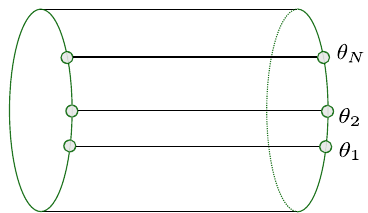
Figure 15 . Graphical representation of the excited state partition function. A physical particle serves as a defect operator with transmission factor T ( u ) = S ( iπ with rapidity θ j